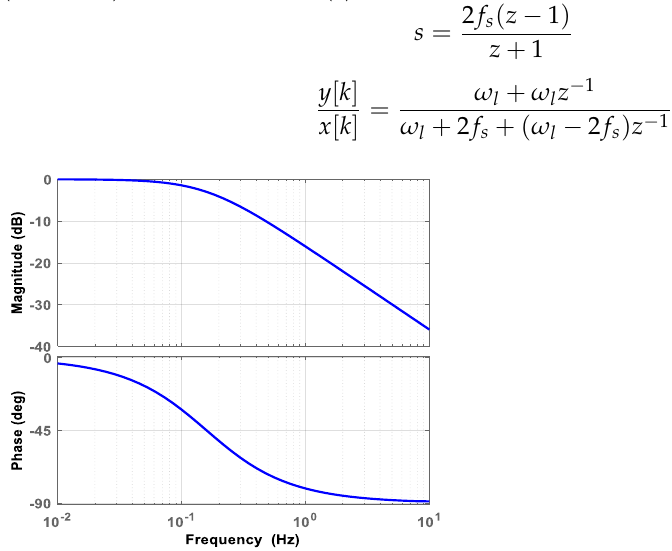
Figure 7. Bode diagram of the first-order low-pass filter.